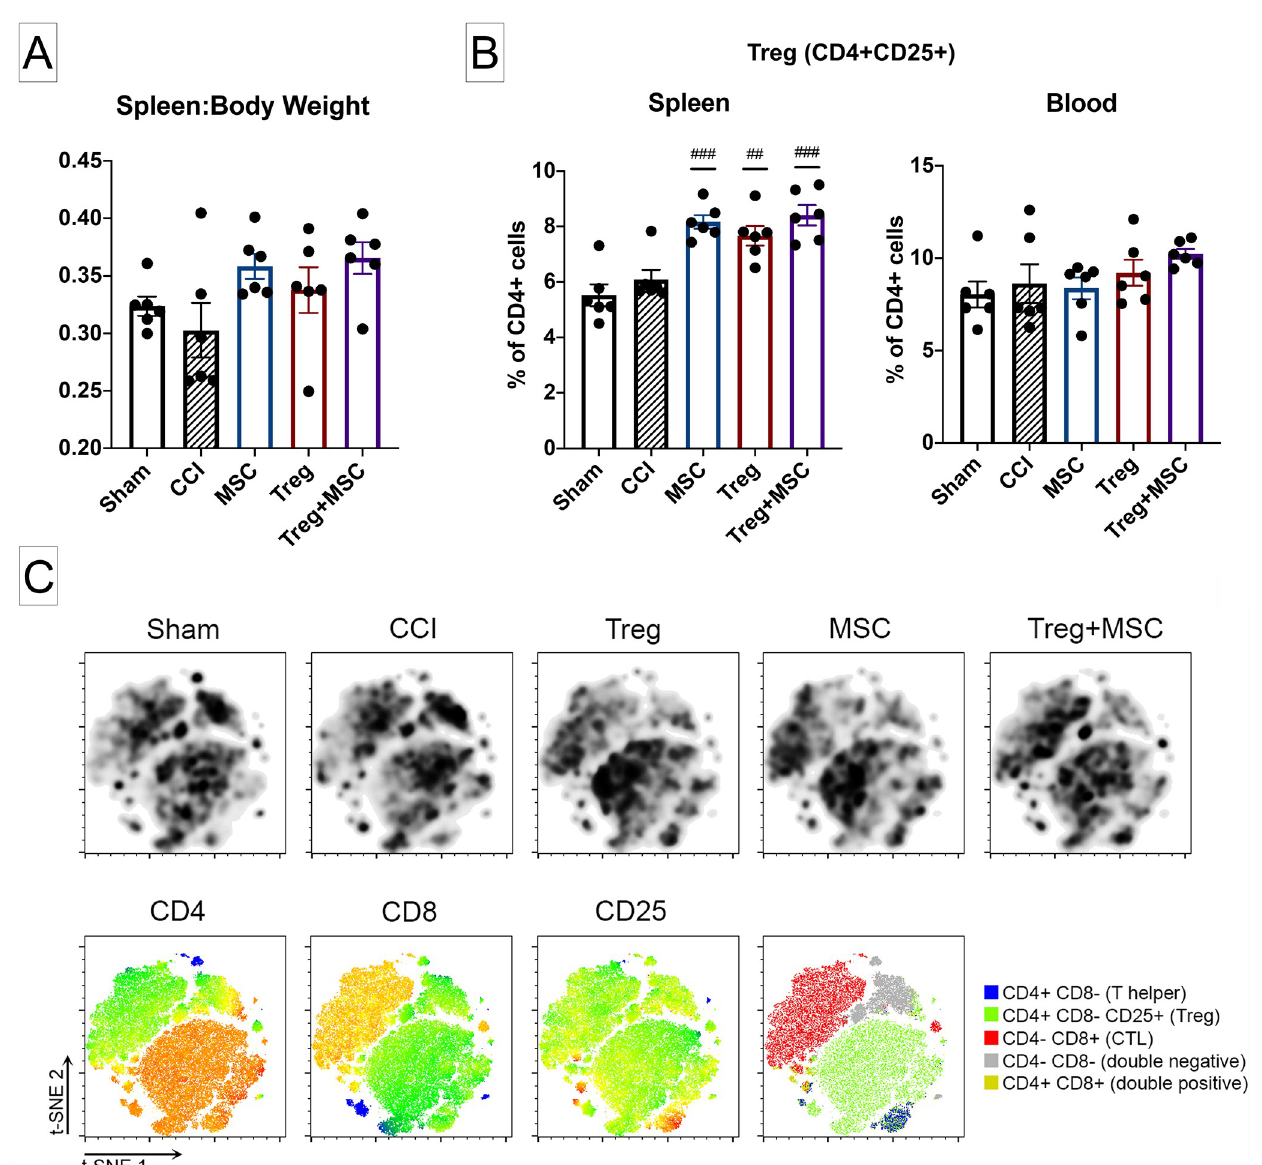
Fig 3. Changes in splenic weight and flow cytometric characterization of immune cells in the spleen and blood after CCI and treatment. (A) : Assessment of changes in the ratio of spleen to body weight at 96 hours after CCI. There were no significant differences between sham and CCI. However, there was a trend towards increased spleen:body weight after Treg+MSC (p = 0.055). (B) : Quantification of CD4+CD25+ rat Treg in the spleen and blood after CCI and treatment using flow cytometry logic-based gating. While there were no significant differences Sham and CCI in the spleen or blood, all three treatments increased the percentage of splenic Treg. There were no differences between treatments. (C) : t-SNE visualization of change in CD3+ T cell populations in the spleen after CCI and treatment. Density plots (top row) demonstrate distinct differences in cell clusters in the injured and treatment animals (black boxes). Analysis of antibody heat maps (bottom row) show that these boxed clusters are largely CD4+CD25+ cells. N = 6. Statistical significance between sham/treatment and CCI is indicated with (#) for p � 0.05, (##) for p � 0.01, (###) for p � 0.001. Statistical significance between treatment groups is indicated with ( � ) for p � 0.05, ( �� ) for p � 0.01, ( ��� ) for p � 0.001. CCI, controlled cortical impact; Treg, regulatory T cell; t-SNE, t- distributed stochastic neighbor